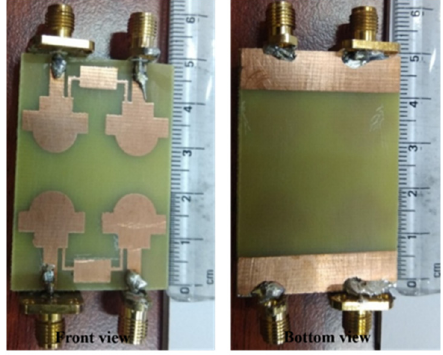
Figure 5. Fabricated 4 × 4 MIMO antenna design [22].